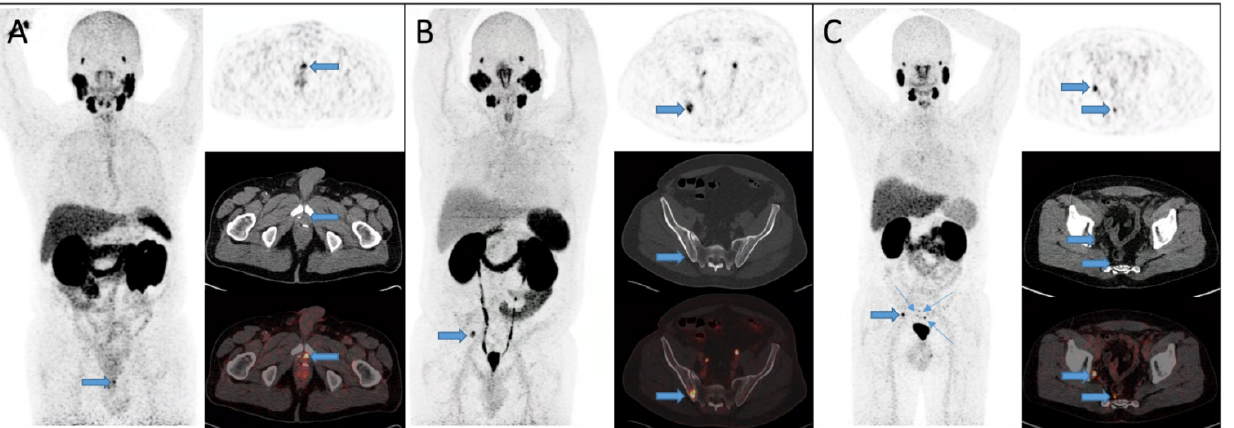
Figure 3. Patients with detected relapse on 68 Ga-PSMA PET/CT. ( A ) A 75 year-old man with biochemical recurrence (PSA = 0.5 ng/mL) seven years after radical prostatectomy. Local relapse was visualized on 68 Ga-PSMA PET/CT just anterior to the surgical clips (arrows). Subsequently, radiation therapy was performed on the relapse, and now four years later the patient has unmeasurably low PSA. ( B ) A 67 year-old male with biochemical recurrence (PSA = 5 ng/mL) after salvage radiation therapy. A bone metastasis in the right iliac bone was found (arrows). Subsequently the patient underwent stereotactic radiation therapy of the metastasis with currently two years free of progression. ( C ) A 59 year-old man with biochemical recurrence (PSA = 1.6 ng/mL) three years after radical prostatectomy. 68 Ga-PSMA PET/CT showed small pelvic and mesorectal lymph node metastases (arrows).